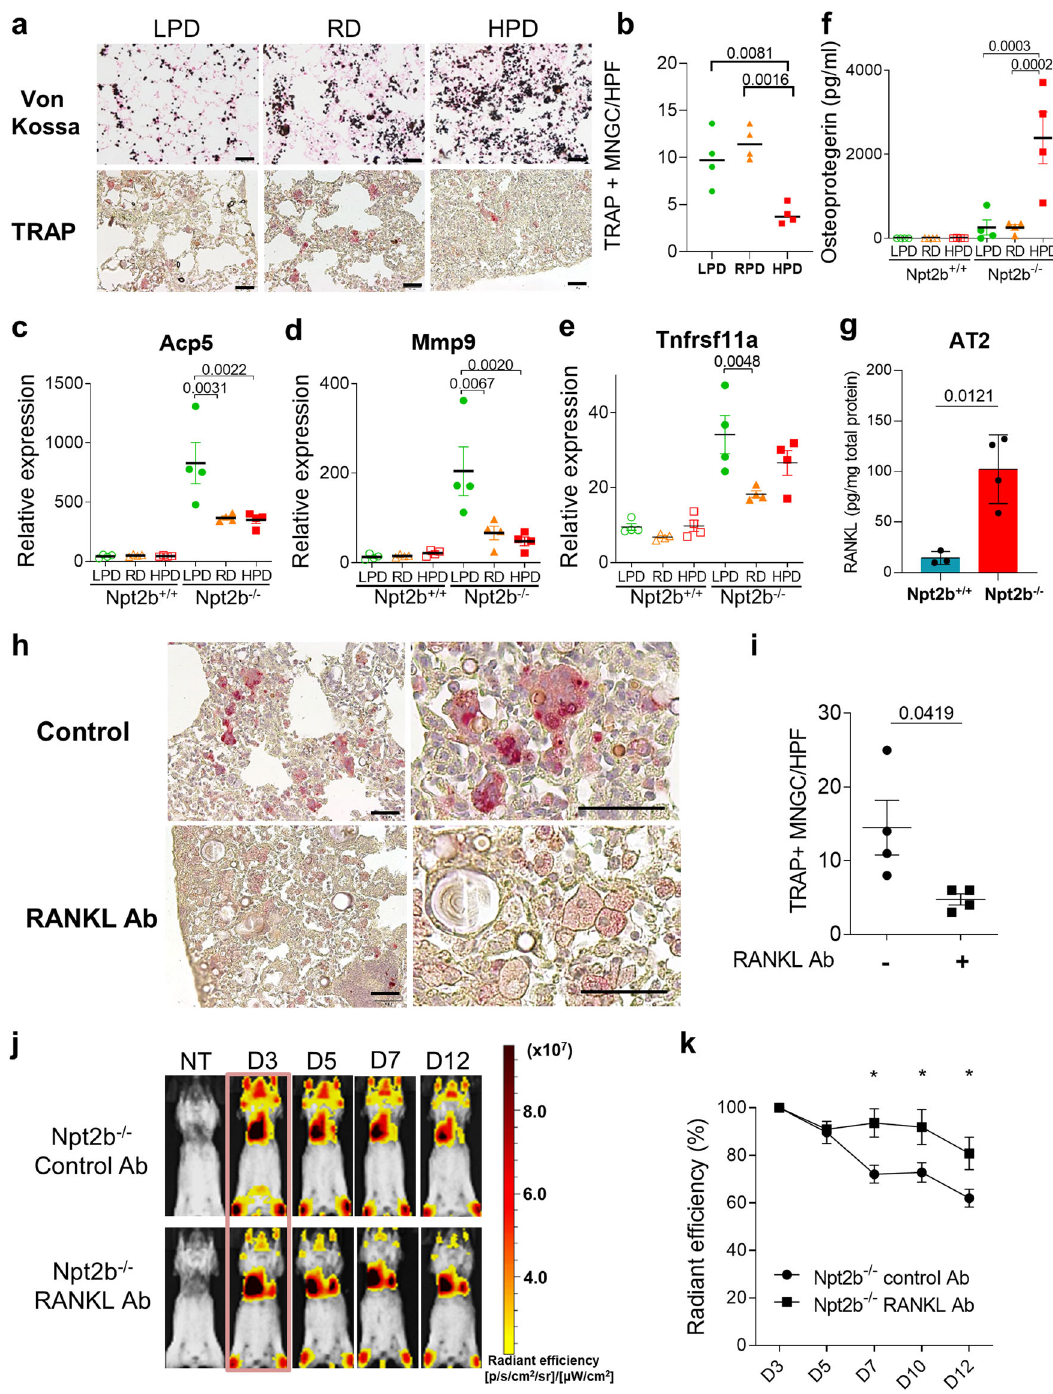
Fig. 7 | RANKL-dependent osteoclast activity is required for microlith clear- ance. a , b Five to six-week-old Npt2b +/+ and Npt2b − / − mice were fed with regular 0.7% Pi diet (RD)for 2 weeks aspretreatment, then fed RD, 0.02% Pi (LPD) or 2% Pi (HPD). Von Kossa and TRAP staining of the lung after 2 weeks of RD, LPD and HPD treatment ( a ) and TRAP positive MNGCs were counted in 10 random high-power fi elds(HPF)(×100)andtheaveragenumberwasusedforanalysis.Scalebars,50 μ m ( b ). Relative expression of Acp5 ( c ), Mmp9 ( d ) and Tnfsfr11a ( e ) in the whole lung and osteoprotegerin levels ( f ) in BALF were determined by RT-PCR and ELISA respectively after 1 week of RD, LPD and HPD treatment. n =4 mice per group. g RANKLlevelsinAT2celllysatefromNpt2b +/+ andNpt2b − / − miceweremeasuredby ELISA. n =3 for Npt2b +/+ mice and n =4 for Npt2b − / − mice per group. h , i Npt2b − / − mice were treated with the RANKL neutralizing antibody or a rat IgG2a isotype